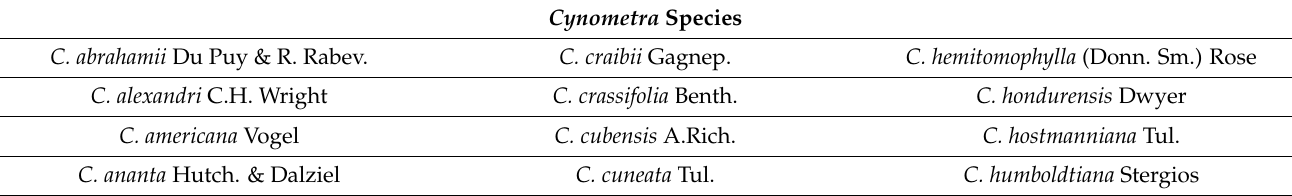
Table 1. Cynometra Table 1. Cynometra species.